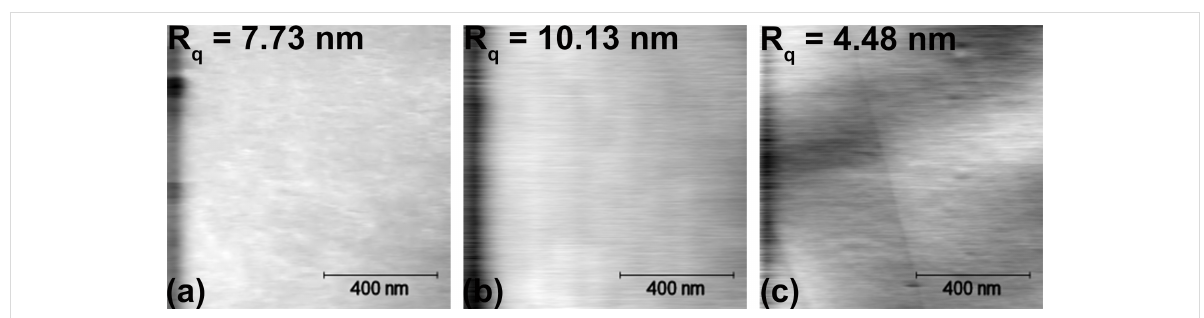
Figure 2: Contact AFM topography images recorded on the surface of eutectic Ga–In–Sn with (a) SiO x , (b) PtSi, and (c) Au AFM tips. We set the normal force to F n = 2 nN and the scanning velocity to v s = 4 µm/s.